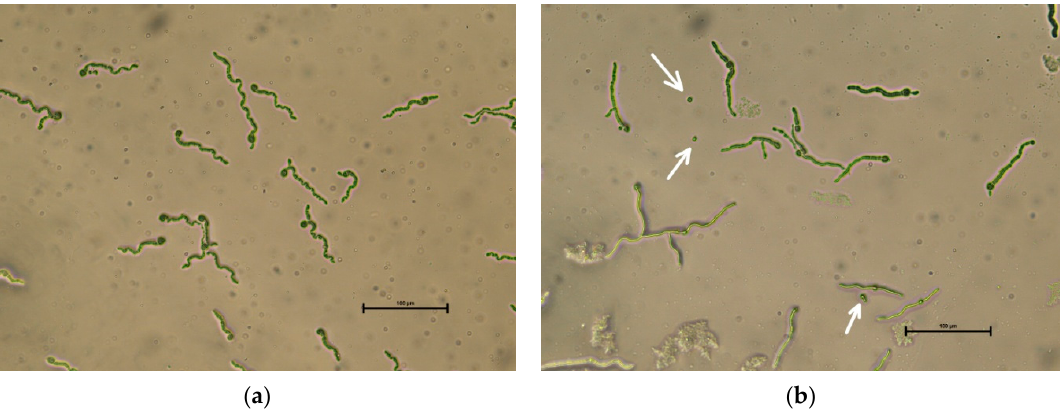
Figure 5. Germination of Isaria fumosorosea conidia on: ( a ) a control agar plate treated with solvent only; ( b ) agar plate treated with Buxus sempervirens extract. Arrows indicate spores with no or little germination peg. Traces of plant extract are visible on the agar surface.